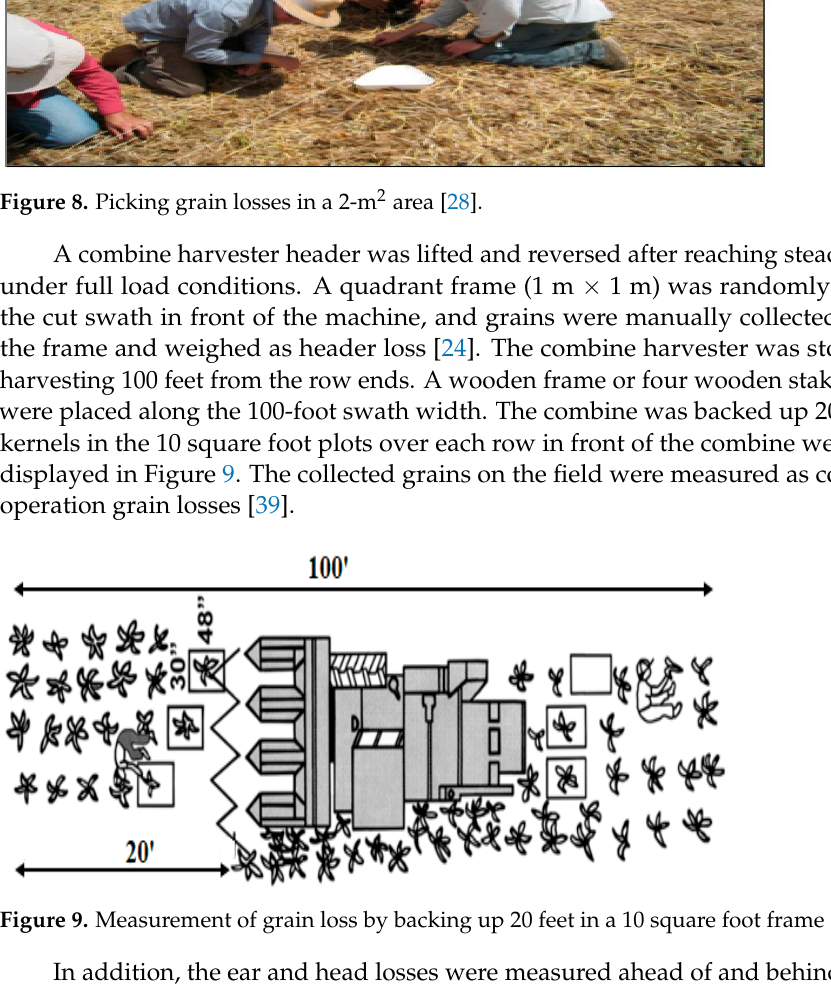
Figure 9. Measurement of grain loss by backing up 20 feet in a 10 square foot frame [39].